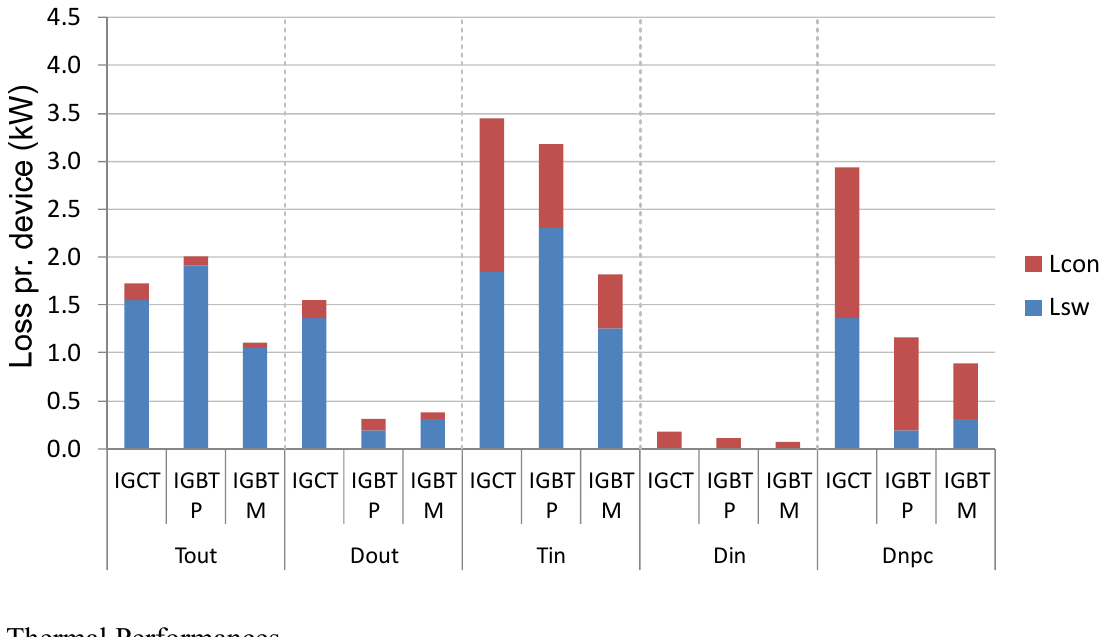
Figure 14. Loss distribution for different power switching device solutions under LVRT operation of Figure 13 (Lcon means conduction loss-red, Lsw means switching